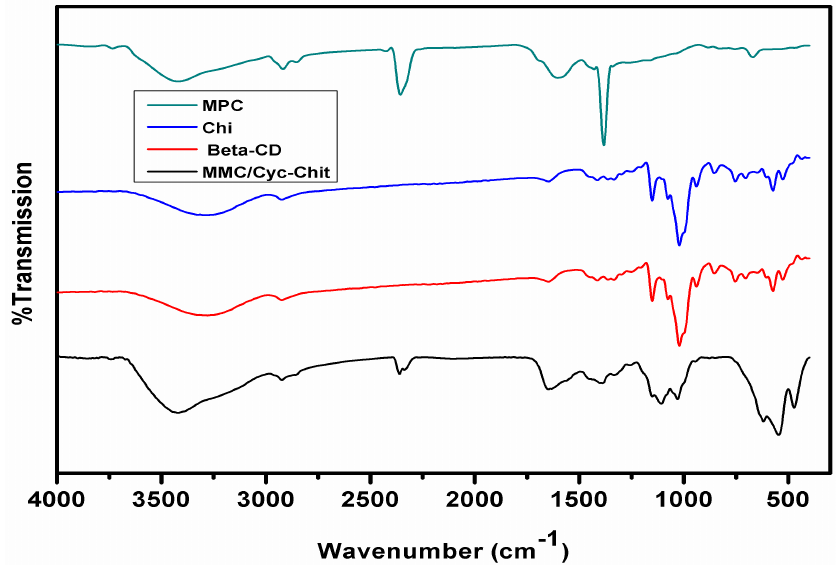
Figure 2. FT-IR spectra of MPC, Chi, beta-CD and MMPC / Cyc-Chit composite.